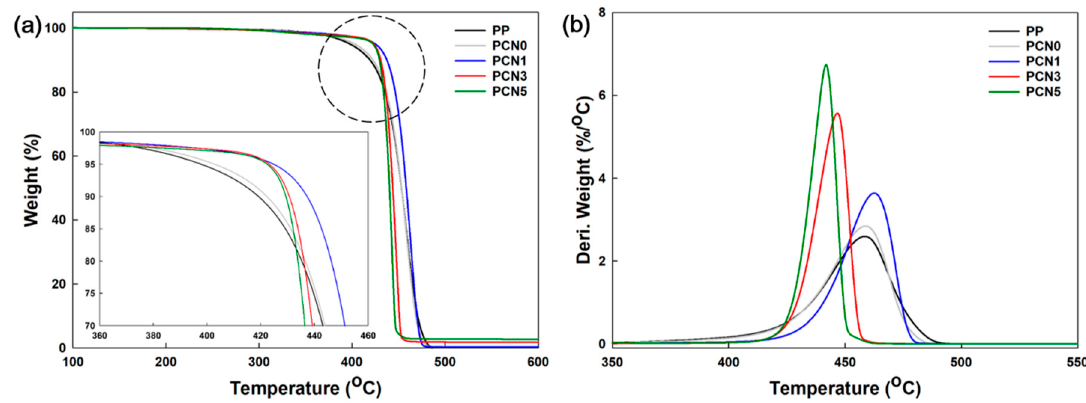
Figure 7. (a) Thermogravimetric analysis (TG) and (b) derivative TG (DTG) curves of PP, PP/CNF, and PP/CNF/nanoclay nanocomposites. and PP / CNF / nanoclay